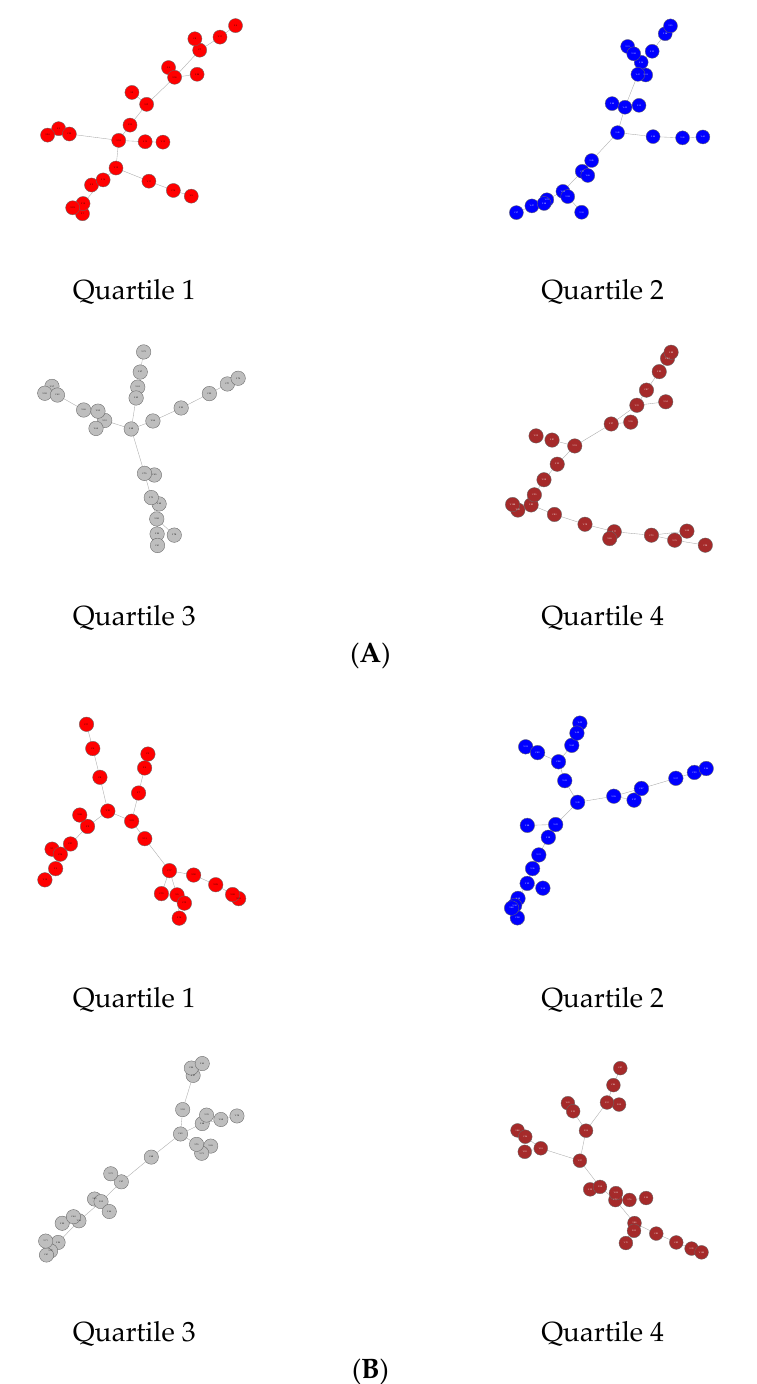
Figure 1. Minimum Spanning Trees (MST) for the ETF industry. This figure shows the resulting MST for two different periods. ( A ) shows a month with higher implied volatility. ( B ) shows a month with lesser implied volatility. We group the ETFs in four quartiles according to their ESG score. Quartile 1 has the lowest ESG score; meanwhile, Quartile 4 has the highest. ( A ) Normal period — October 2017 — VIX level: 9.49; ( B ) COVID-19 outbreak period — March 2020 — VIX level: 53.43. Source: authors ’ elaboration.